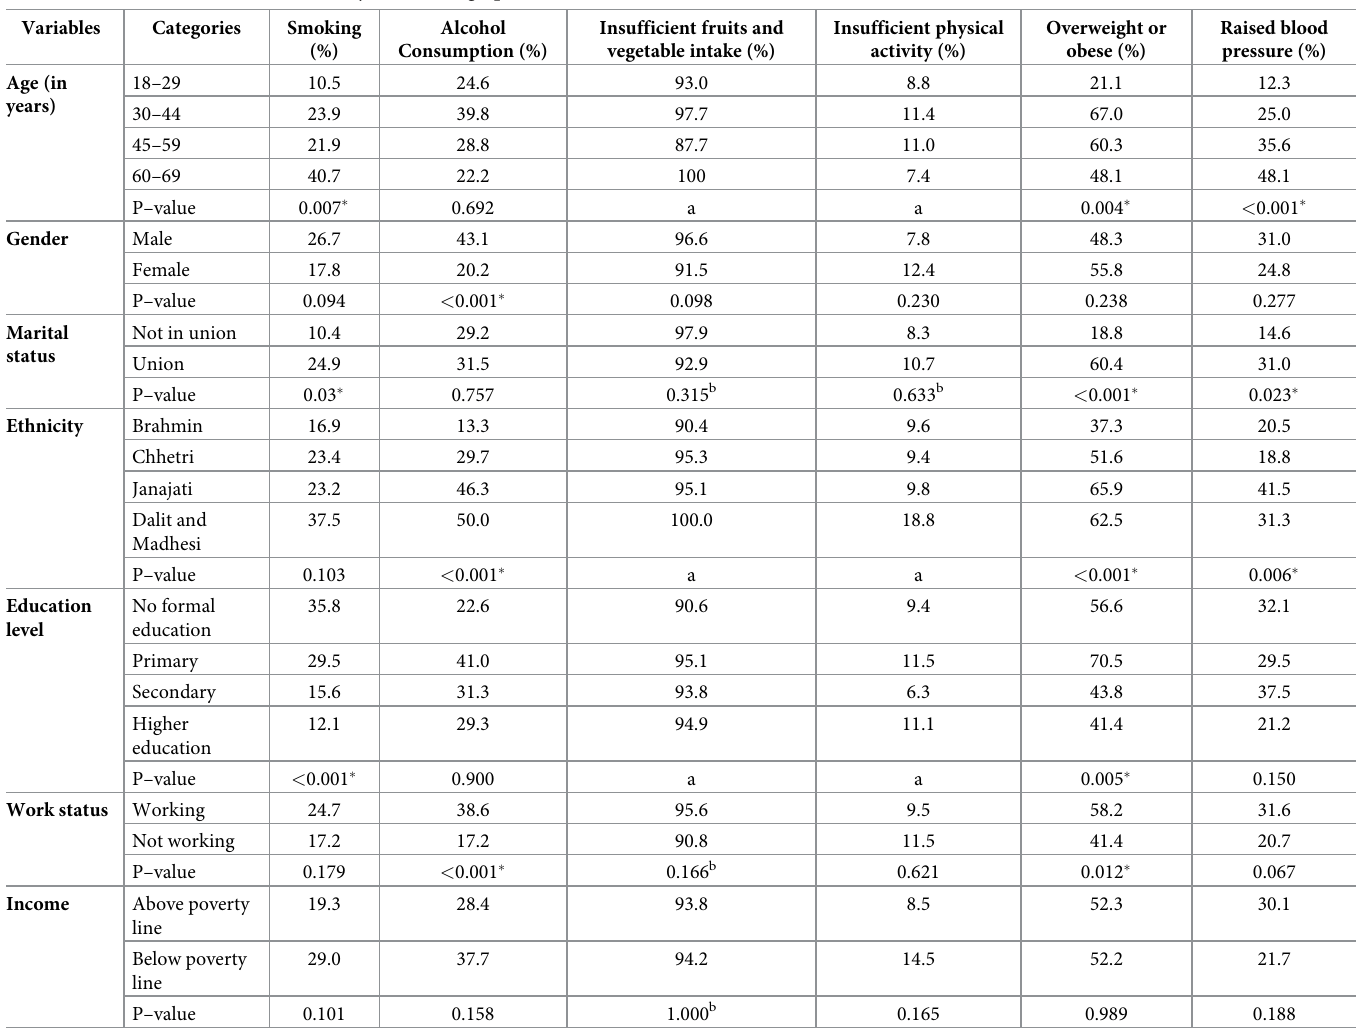
Table 3. Association of NCD risk factors by socio-demographic characteristics (n =